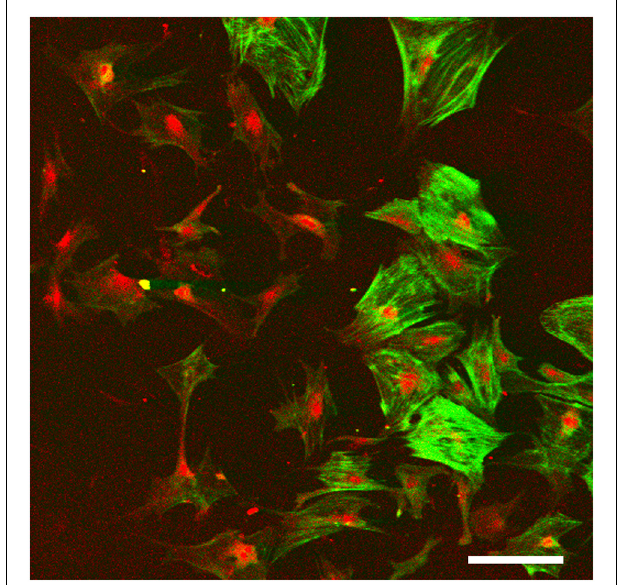
FIGURE 5 | Monolayer fibrocyte culture after immunofluorescence labeling for caldesmon (green) and Na, K, ATPase (red). The cells exhibit a mixed phenotype with some cells labeled strongly for both, and others labeled primarily for the Na, K, ATPase. Scale bar = 100 µ m. Image taken from conference presentation, cited in published proceedings by Furness